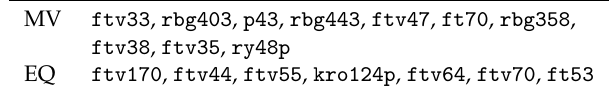
Table 3. Instances for which the Mann Whitney U test supports that there is a significant difference between Multiverse and Multistart Genetic Algorithm in favor of Multiverse (MV) or no difference (EQ). There is no instance so that there is a difference in favor of